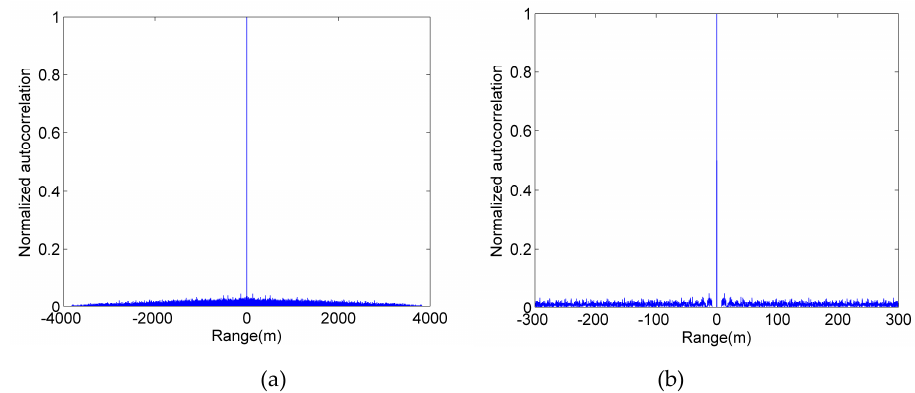
Figure 2. Autocorrelation function of the second modulated pseudo-random sequence. ( a ) global ( b ) local enlarged.